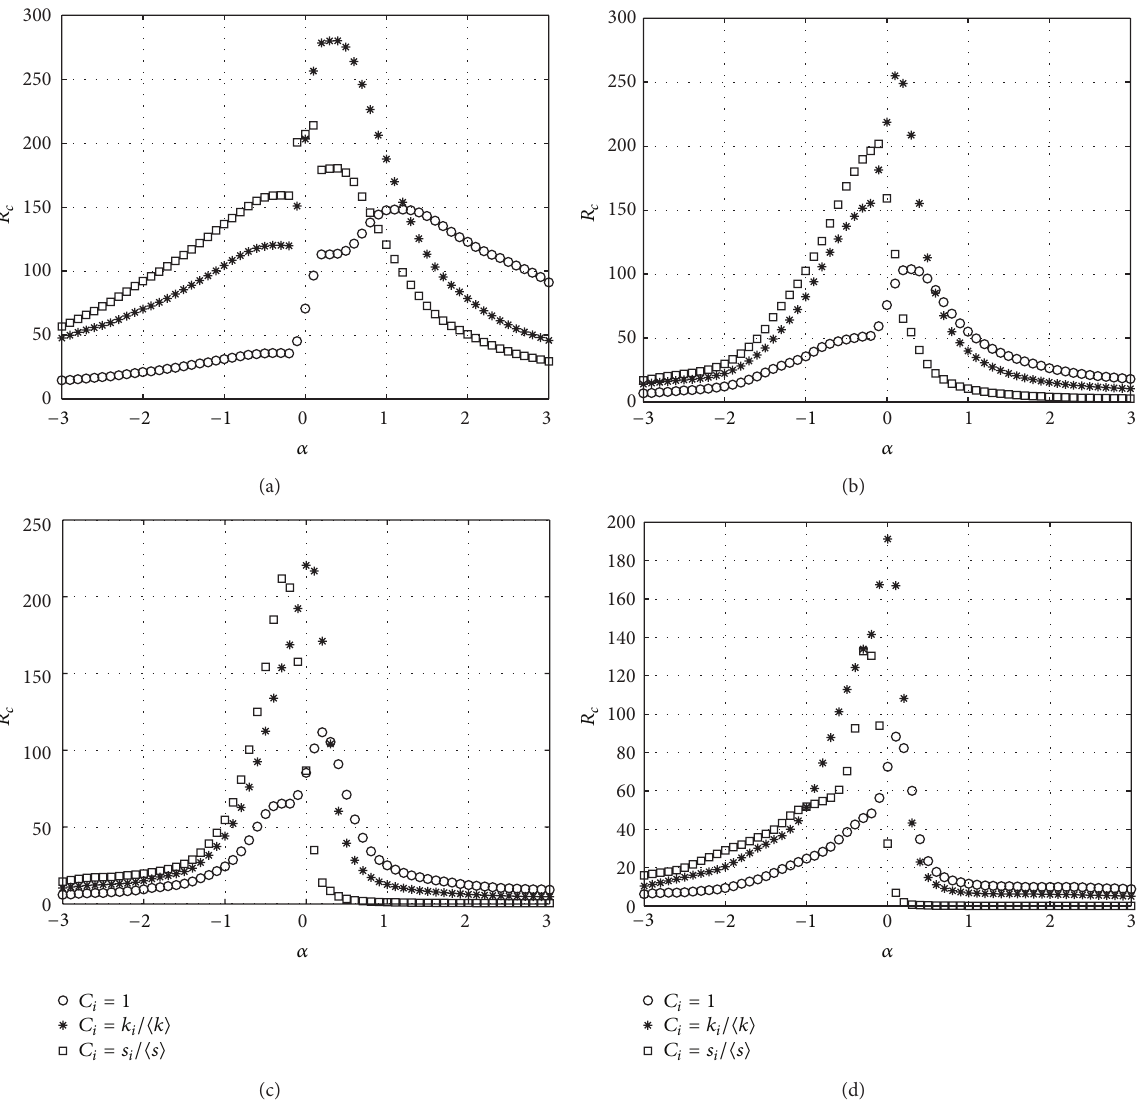
Figure 2: 𝑅 𝑐 versus 𝛼 . BBV network with 𝑛 = 1000 , 𝑚 = 6 , and 𝜔 0 = 1 . (a) 𝛿 = 0.6 , (b) 𝛿 = 3 , (c) 𝛿 = 12 , and (d) 𝛿 = 60